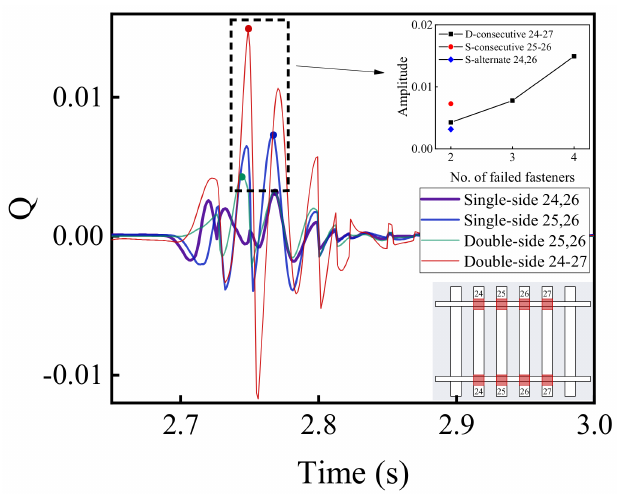
Figure 26. The time-history variations of wheel load reduction rate with different patterns of rail fastener failure.